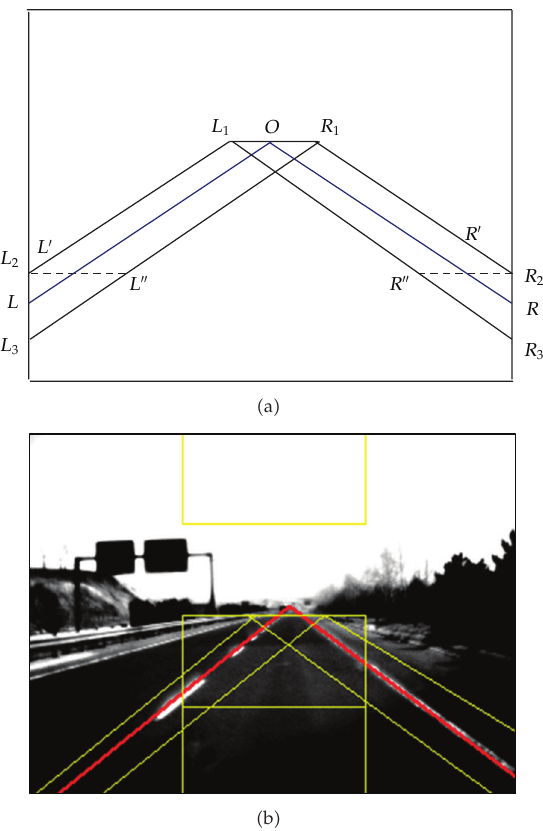
Figure 2: Schematic of feature regions division in tracking